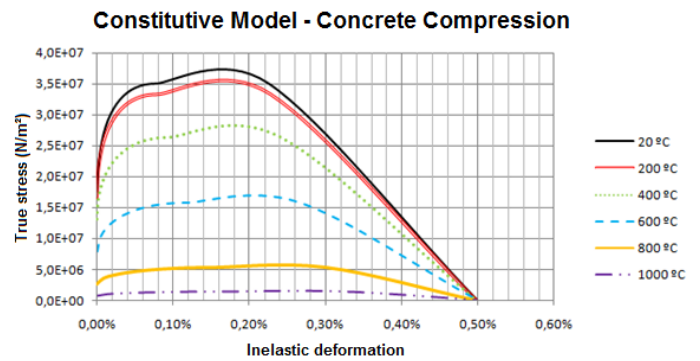
Figure 6. Concrete mechanical properties under